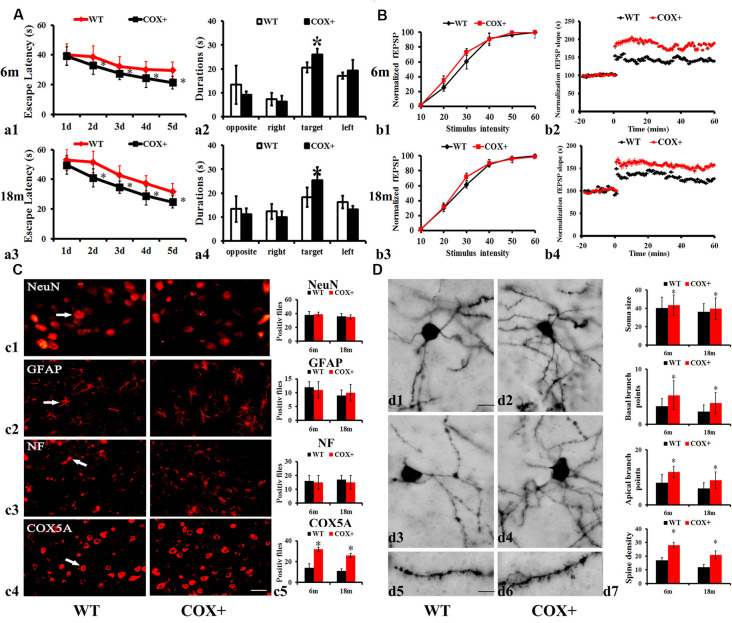
Effects of COX5A overexpression in mice. (A) Average escape latency (a1,a3) and the duration in the target quadrant (a2,a4) evaluated by the Morris Water Maze (MWM) test in 6-months-old (a1,a2) and 18-months-old (a3,a4) COX5A-UP transgenic (Tg) and age-matched WT mice. Opposite, the opposite quadrant; right, the right quadrant; target, the target quadrant; left, the left quadrant. * vs. WT mice, P < 0.05. Values plotted to represent the mean ± SD (n = 10). (B) Synaptic LTP of the hippocampus in COX5A-UP Tg mice and WT mice. Values plotted to represent the mean ± SD (n = 5). * vs. WT mice, P < 0.05. (C) Morphologic changes in COX5A-UP Tg mice. (c1–c4) NeuN, GFAP, NF, and COX5A, respectively; Magnification: 200×, Scale bar: 10 μm. (D) Representative images of neurons with Golgi stains in 6-months-old (d1,d5) and 18-months-old (d3) WT mice, as well as in 6-months-old (d2,d6) and 18-months-old (d4) COX5A-UP Tg mice. The quantification of changes in dendritic cells is shown in (d7). Magnification: (d1–d4): 200×, Scale bar, 10 μm; (d5) and (d6): 400×; Scale bar, 5 μm. COX+, COX5A-UP Tg mice; WT, wild type mice.